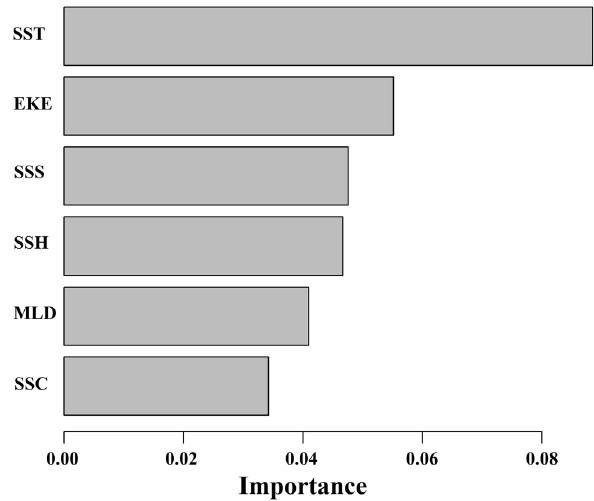
Figure 7. Importance of environmental variables (SST, SSC, SSS, SSH, MLD, and EKE) across CPUE 1 outputs (R 2 ) according to gradient forest